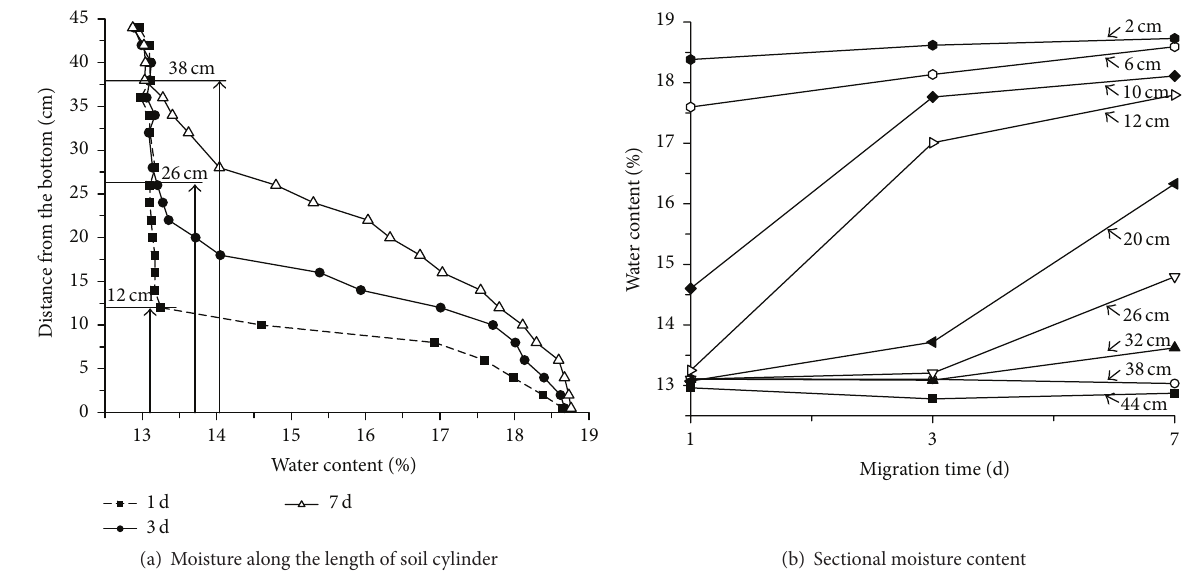
Figure 6: Distribution of water content in the ground water level simulation tests.